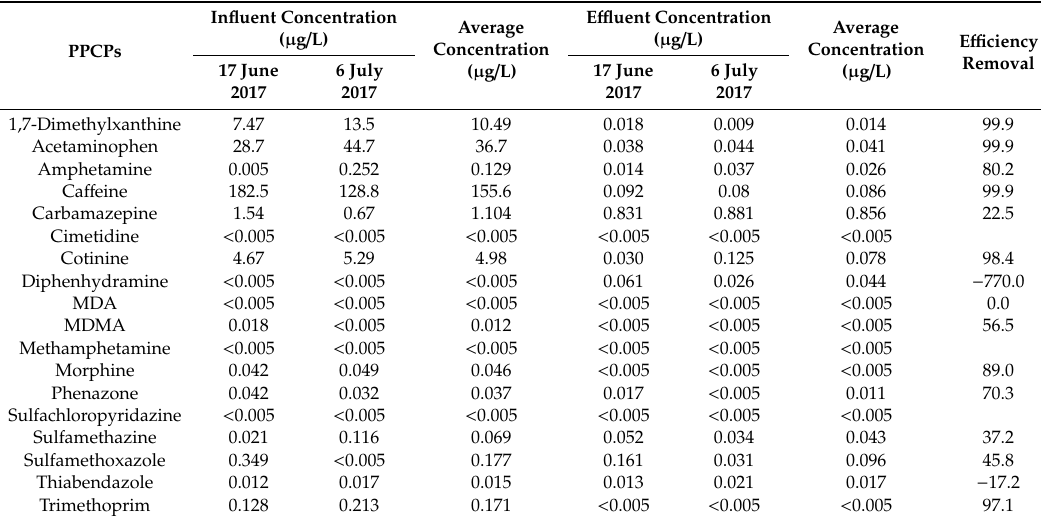
Table 3. Concentrations of pharmaceuticals and personal care products detected in collected grab (ppb) from As-Samra